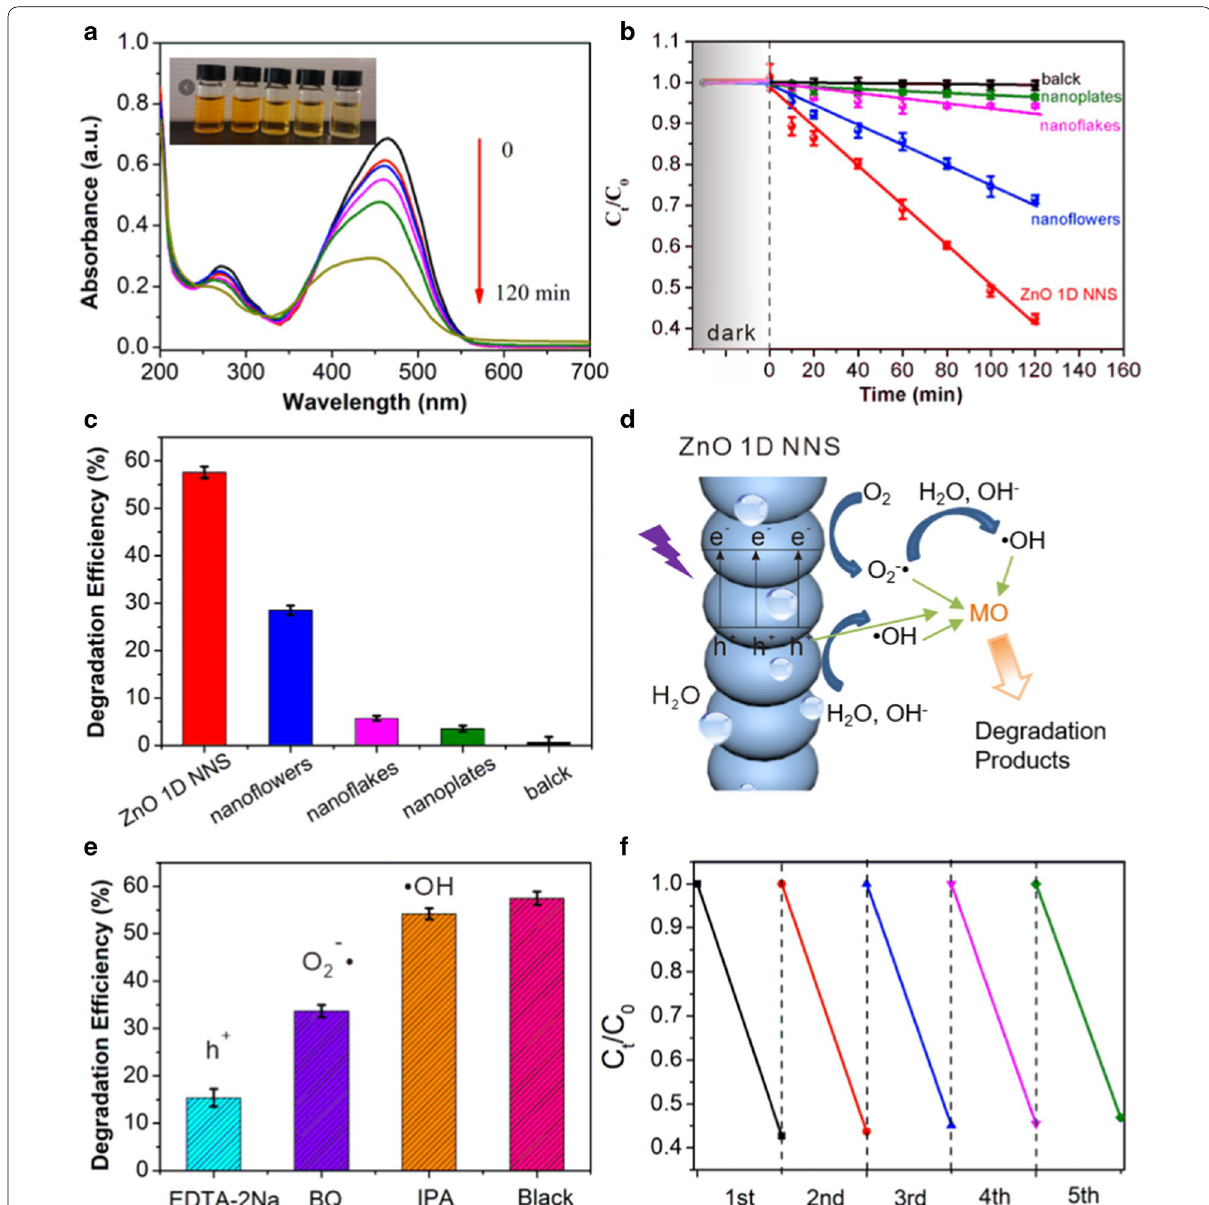
Fig. 5 The study of photocatalytic performance of ZnO catalyst. a Photodegradation curves of MO solution by using ZnO 1D NNS as catalyst under irradiation with UV light. Inset shows the optical photographs of MO solution along the UV irradiation. b The kinetic relationship of C t / C 0 versus irradiation time curves. c The calculated degradation efficiency by using different ZnO nanostructures. d Schematic representation of photocatalytic process. e The degradation efficiency in the presence of different radical scavengers. f The reuse activity of ZnO 1D NNS for the photodegradation of